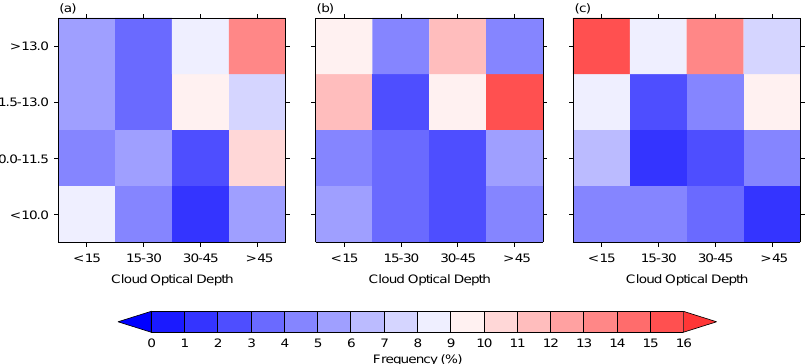
Figure 6. Cloud frequency of occurrence at three levels of CN concentration: (a) 0–2000cm − 3 , (b) 2000—4000cm − 3 , and (c) 4000– 6000cm − 3 . Data are binned according to COD and cloud-top